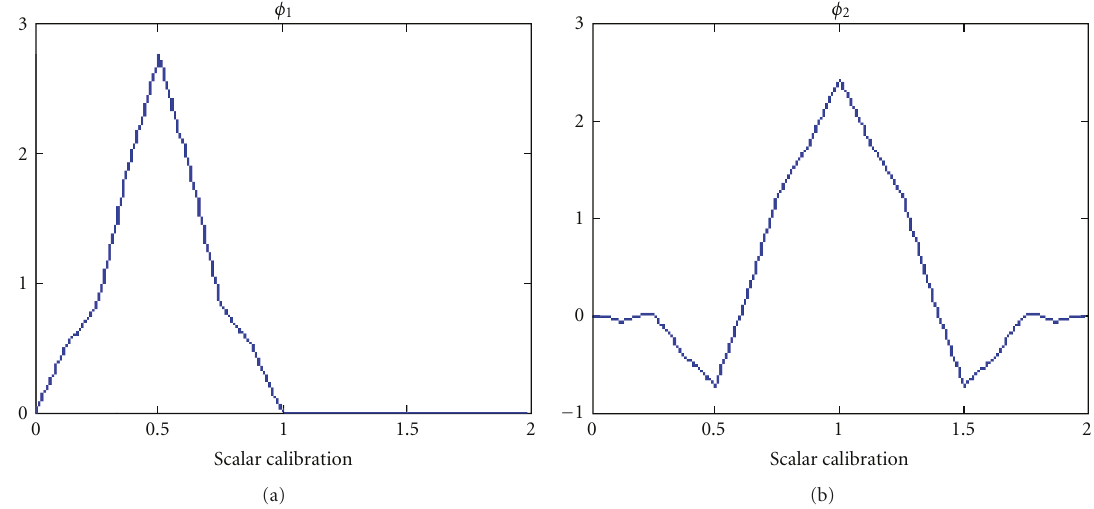
Figure 1: The scaling functions on interval [0, 2] generated by the new lengh-5 low-pass